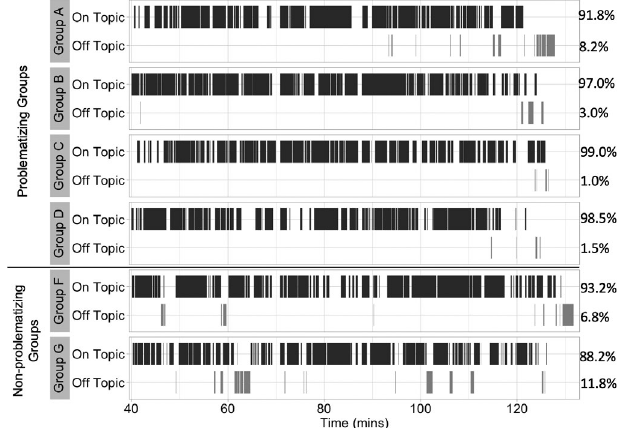
FIG. 6. Timeline of on- and off-topic speech for the six codeable groups, along with the cumulative percentage of speech that is on or off topic. Silence and extended inaudible speech are excluded from the percentages and appear as gaps in the timeline. Groups F and G are the only two to spend substantial time off topic in the middle of the lab. Off-topic discussion at the end of the lab for all groups includes discussion about the learning management software used for submitting their